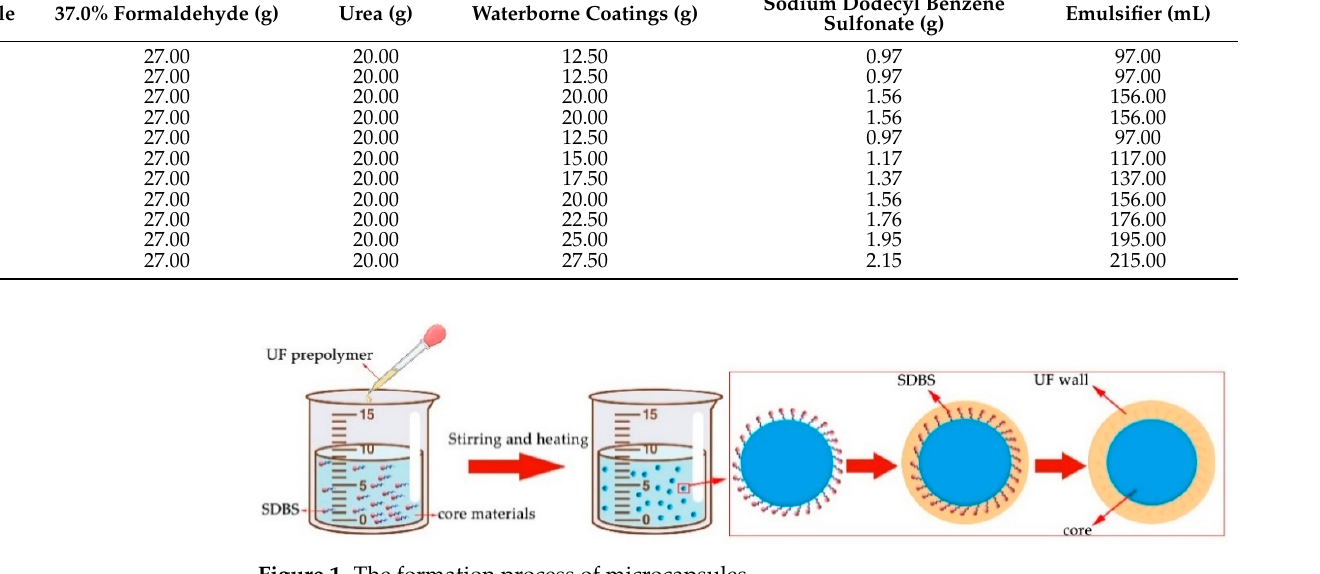
Figure 1. The formation process of microcapsules. Table 3. Detailed list of various substances used in orthogonal and single factor tests.